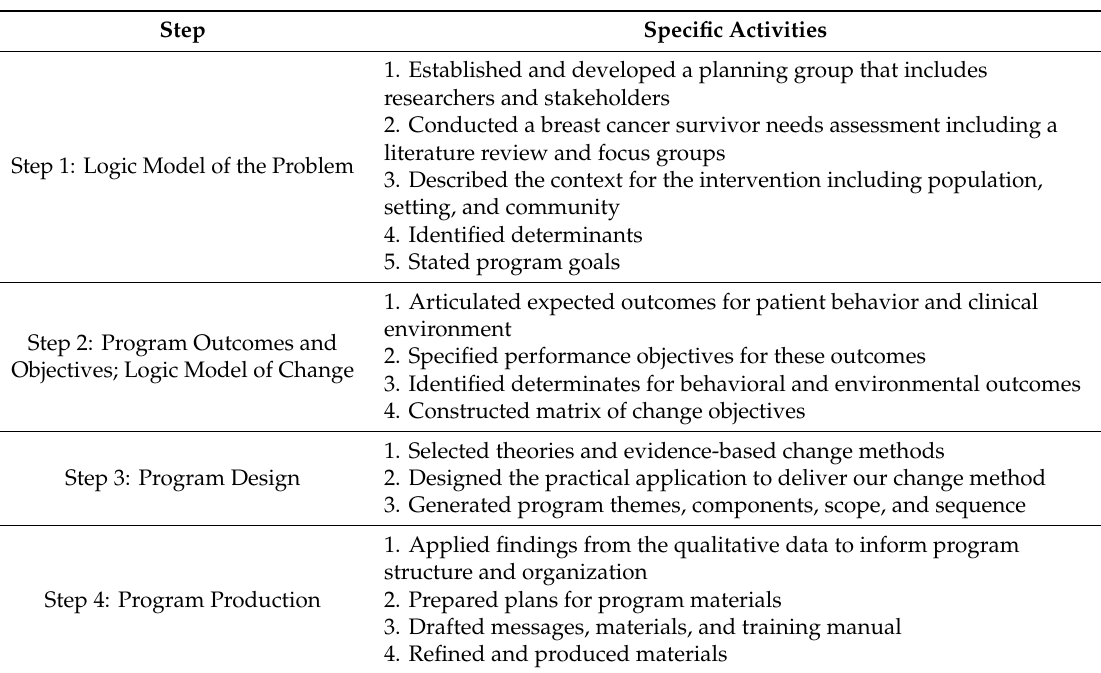
Table 1. Steps and Activities for the Development of Proyecto Mariposa